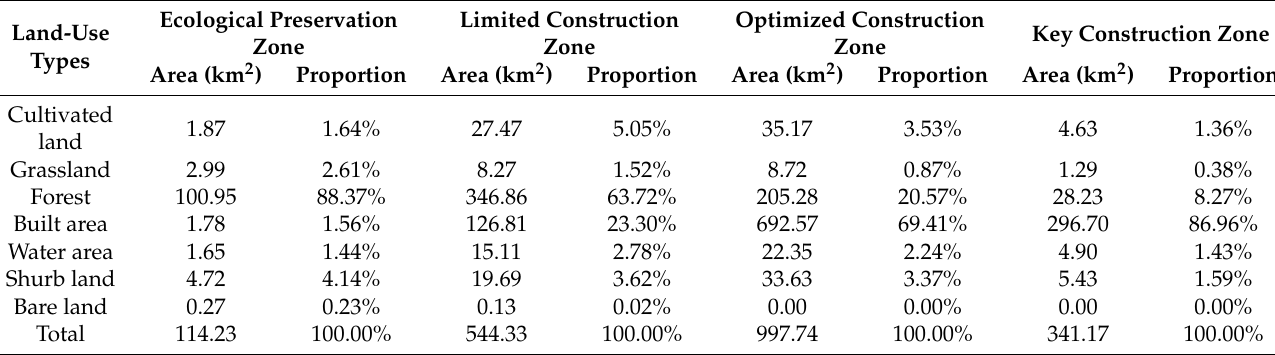
Table 7. Land-use types in ecological security zones.